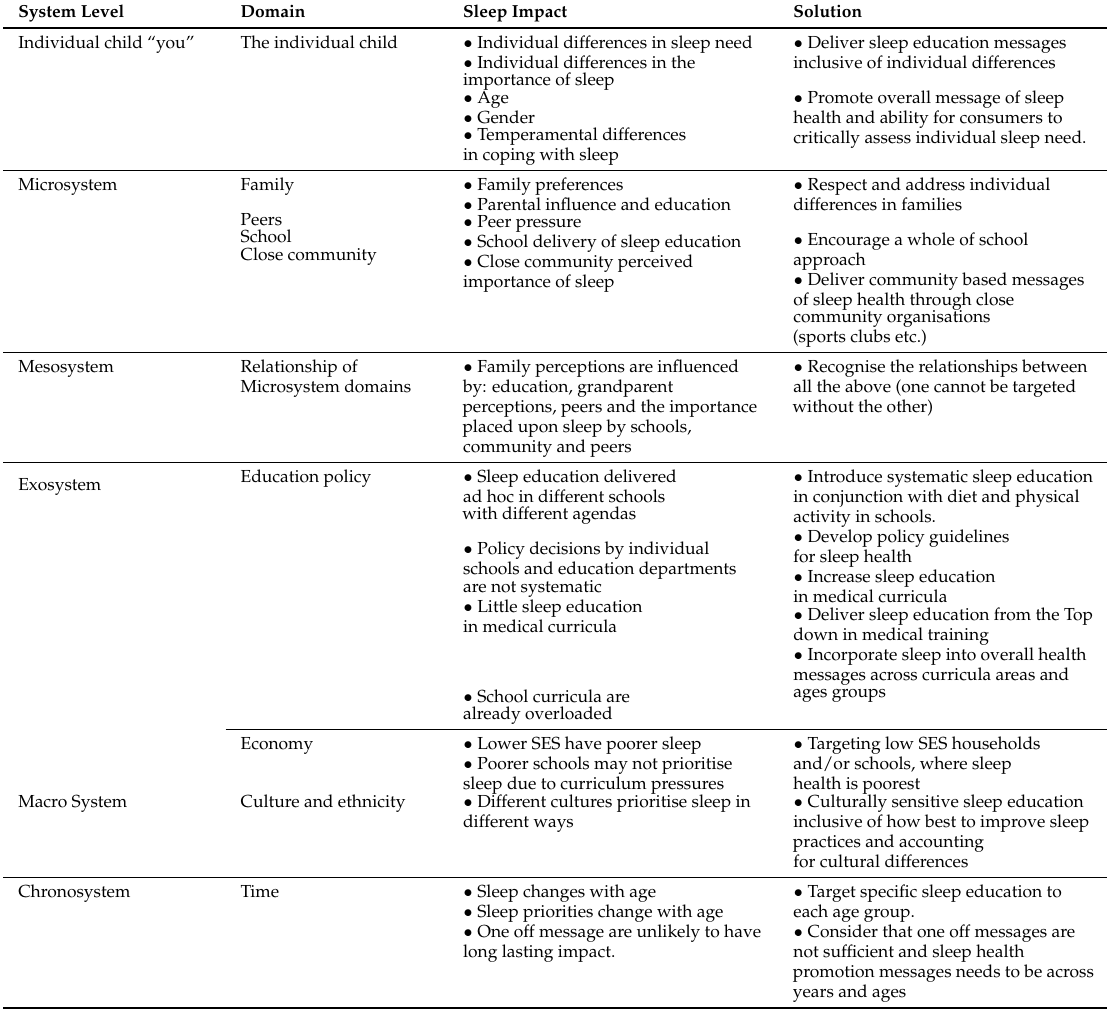
Table 1. Brofenbrenner’s ecological systems approach to sleep